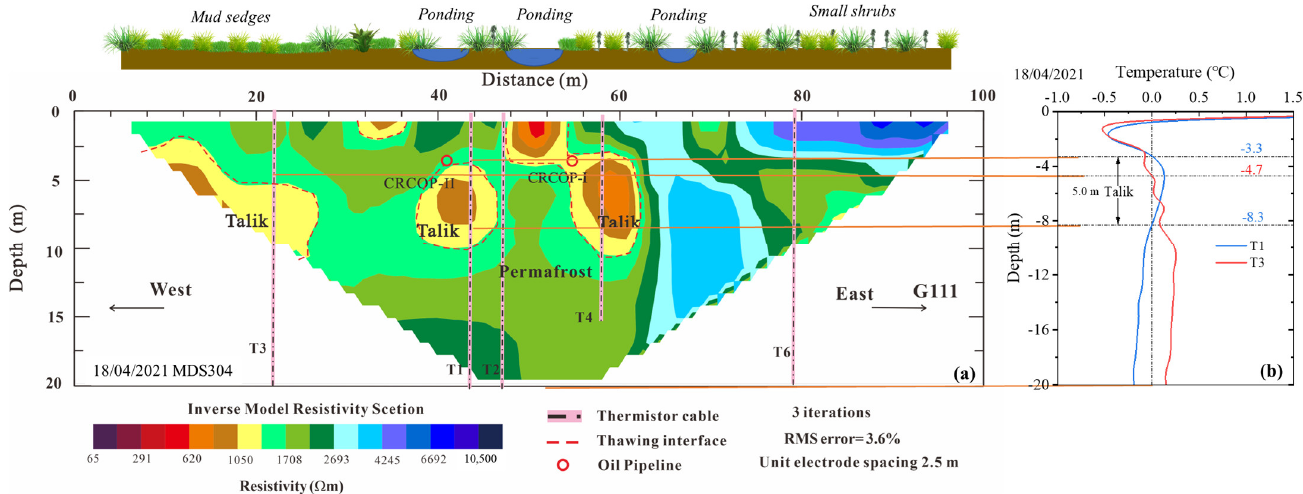
Figure 11. On 18 April 2021, an inversion profile of the ERT test results with an RMS error of 3.6% was obtained at the MDS304 site (Profile 1) ( a ), and the curve of ground temperature with a depth of borehole T1 and T3 ( b ). Note: T1,…, T6 is a ground temperature borehole; CRCOP-I: the CRCOP’s first line; CRCOP-II: the CRCOP’s second line.